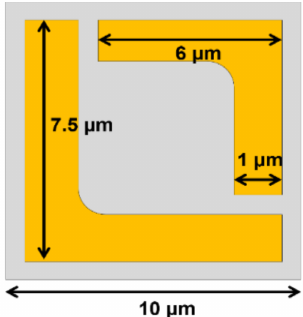
Figure 10. The schematic unit cell proposed from [204] to detect viruses. The periodic pattern is composed of the combination of large L and small